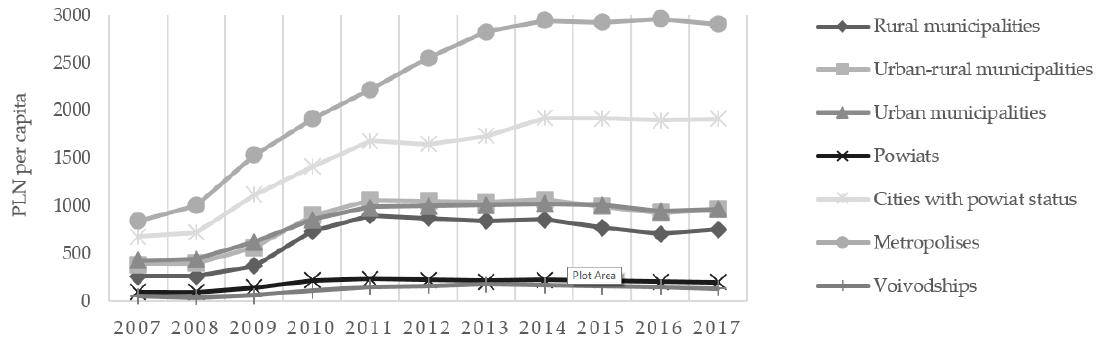
Figure 1. Debt levels of Polish local government units in 2007–2017 (PLN per capita). Source: Own calculations based on data from the Ministry of Finance